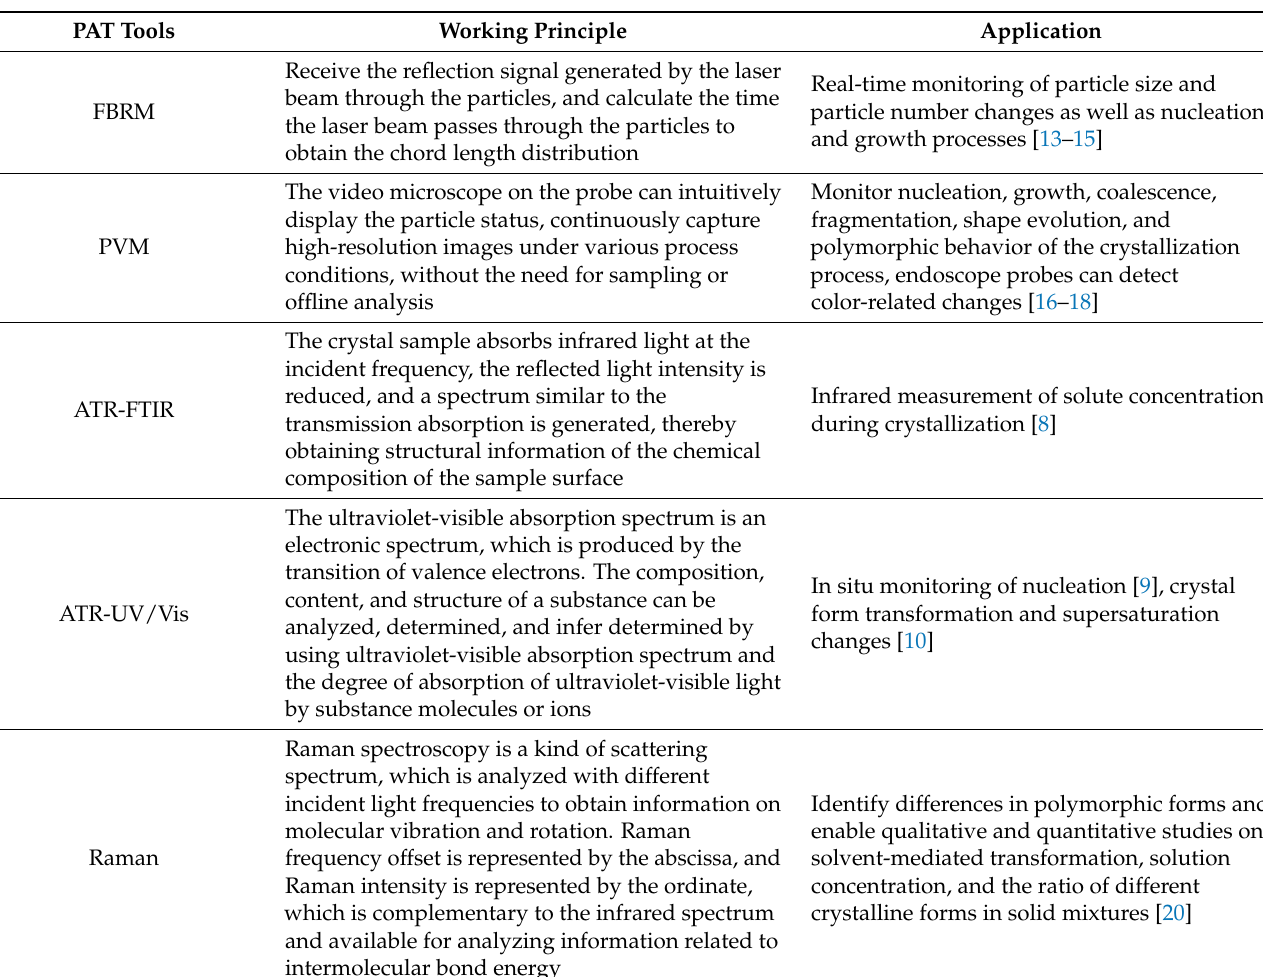
Table 1. Summary of the process analytical technology (PAT) tools in the solution crystallization process. PAT